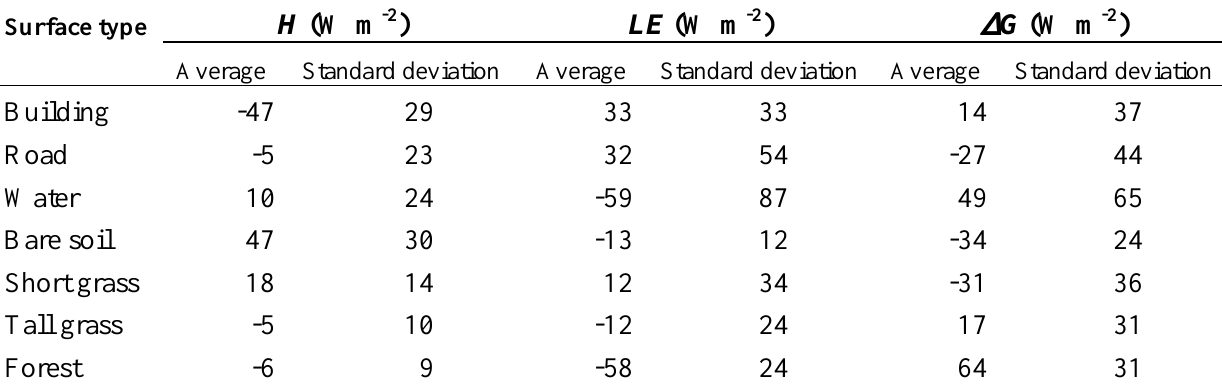
Table 4. Averages and standard deviations of heat flux differences derived from ASTER and Formosat-2 data (Fluxes from Formosat-2 – Fluxes from